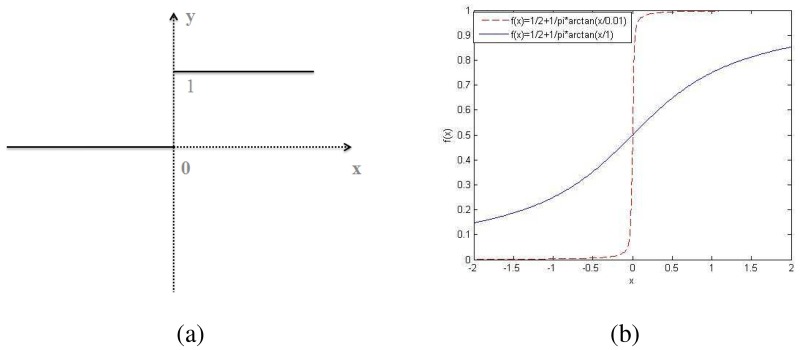
(a) Heaviside function. (b) two approximated Heaviside functions with ξ = 1 (blue solid line) and ξ = 0.01 (red dash line).